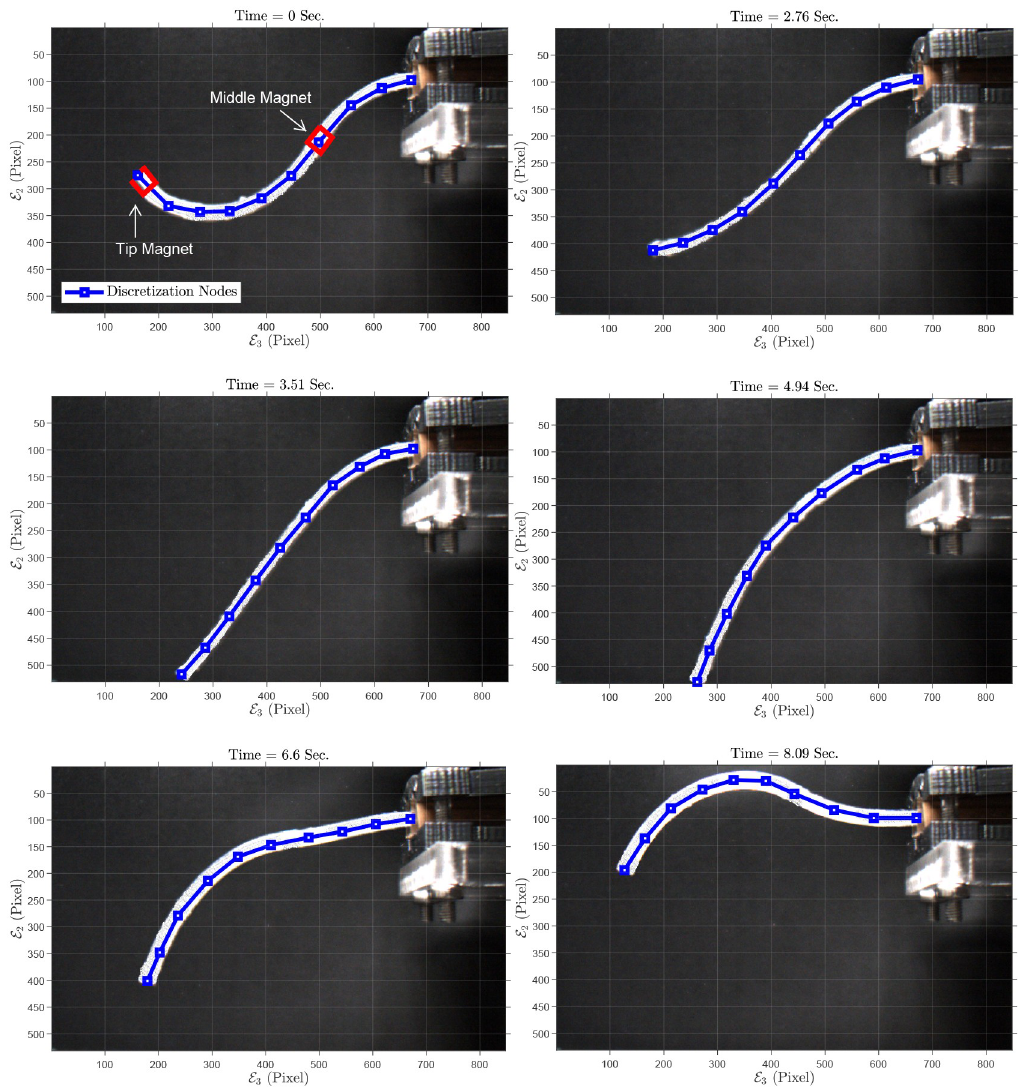
Fig 14. Sample of grabbed images: Polydimethylsiloxane (PDMS) rod with two embedded magnets, 2D experiment: Motion in a plane. Also, 10 discretization points, (blue squares,) are shown on the rod.